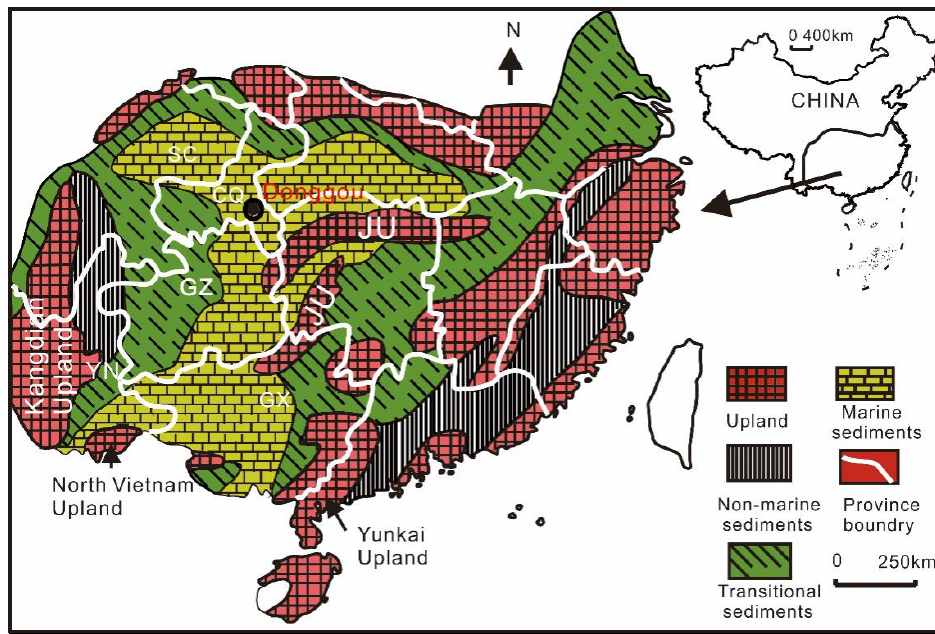
Figure 1. Paleographyofstudyarea,revisedfromDaietal.[37]. JU,JiangnanUpland; YN, Yunnan Province; GX, Guangxi Province; GZ, Guizhou Province; SC, Sichuan Province; CQ, Chongqing